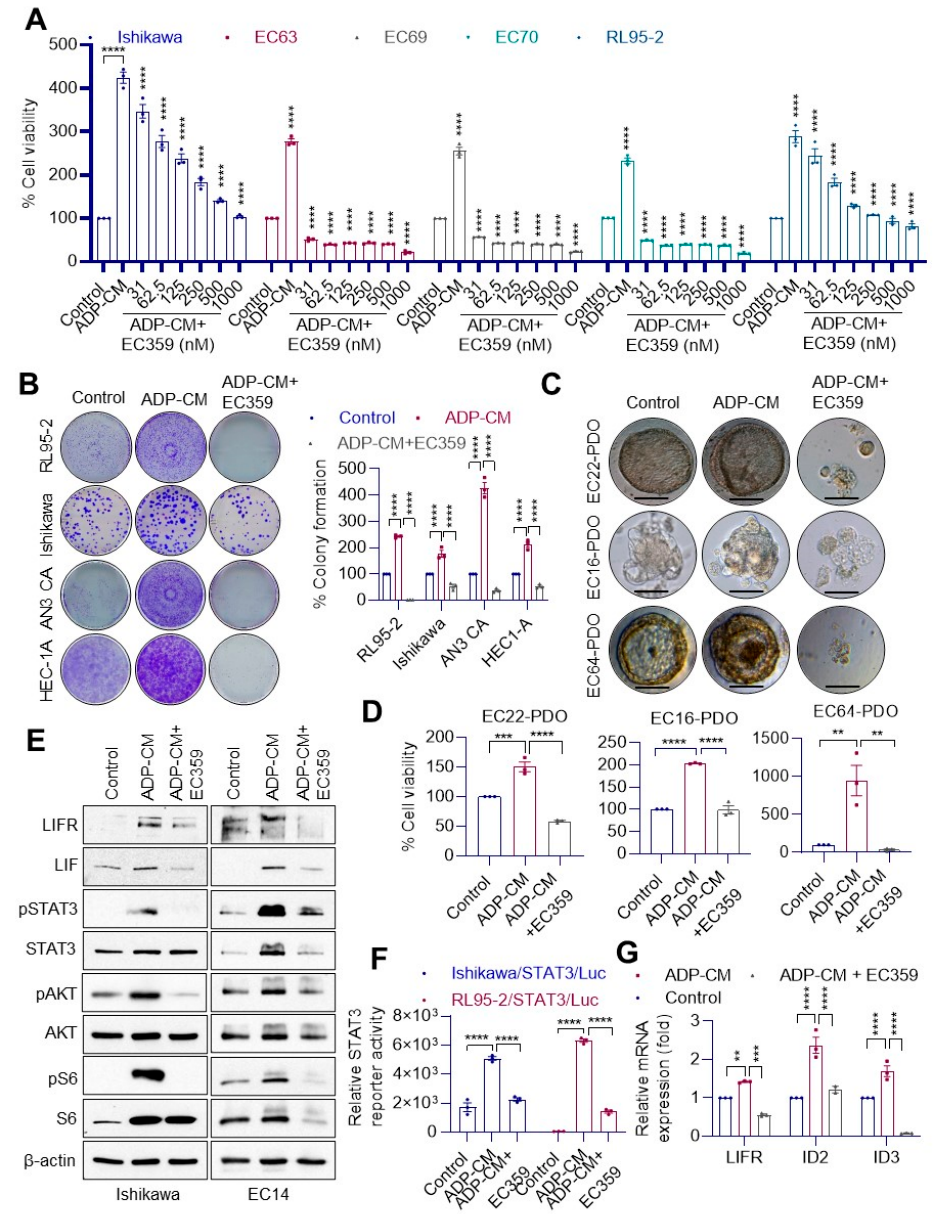
Figure 4. EC359 reduced adiposity-induced cell viability, colony formation and LIFR downstream signaling. ( A ) Established and primary endometrial cancer cells were incubated with ADP-CM with or without EC359 and cell proliferation was determined by MTT cell viability assay. ( B ) Effect of EC359 on adiposity-induced cell survival of EEC cells was measured using colony formation assays, and quantitation is shown on the right panel. ( C ) Representative images of PDOs cultured in ADP-CM in the presence or absence of EC359 are shown. ( D ) Effect of EC359 on adiposity-induced cell viability of organoids was measured using CellTiter-Glo 3D-Superior Cell Viability Assay. ( E ) Ishikawa and primary EEC (EC14) cells were treated with ADP-CM, and expression of LIFR and downstream signaling proteins were analyzed using Western blot analysis. ( F ) EEC cells stably expressing STAT3- luc were treated with ADP-CM in the presence or absence of EC359, and STAT3 reporter activity was measured after 24 h. ( G ) Primary EEC cells (EC16) incubated with ADP-CM with or without EC359, and the expression of LIFR target genes was analyzed by RT-qPCR. Data are represented as mean ± SE. ** p < 0.01; *** p < 0.001; **** p <